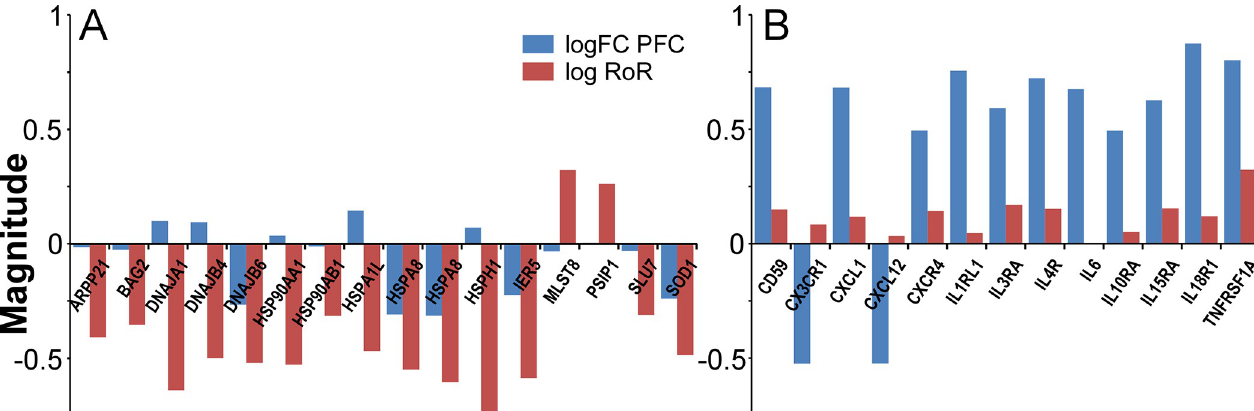
Fig 7. Differential expression of individual members of Gene Sets 1 and 2. The magnitude of log FC and log RoR calculated by Eq (1) (PFC region, blue) and (3) (log RoR, red) were plotted for selected GO biological process enriched genes identified in Fig 6 . ( A ) Contrasting Set 1 genes annotated to “heat cellular temperature” GO categories. Log RoR reveals polarity of changes with respect to tauopathy vulnerability. ( B ) Set 2 genes belonging to interleukin and cytokine signaling pathways. Log RoR values trend toward zero owing to both CB and PFC changing expression in parallel.